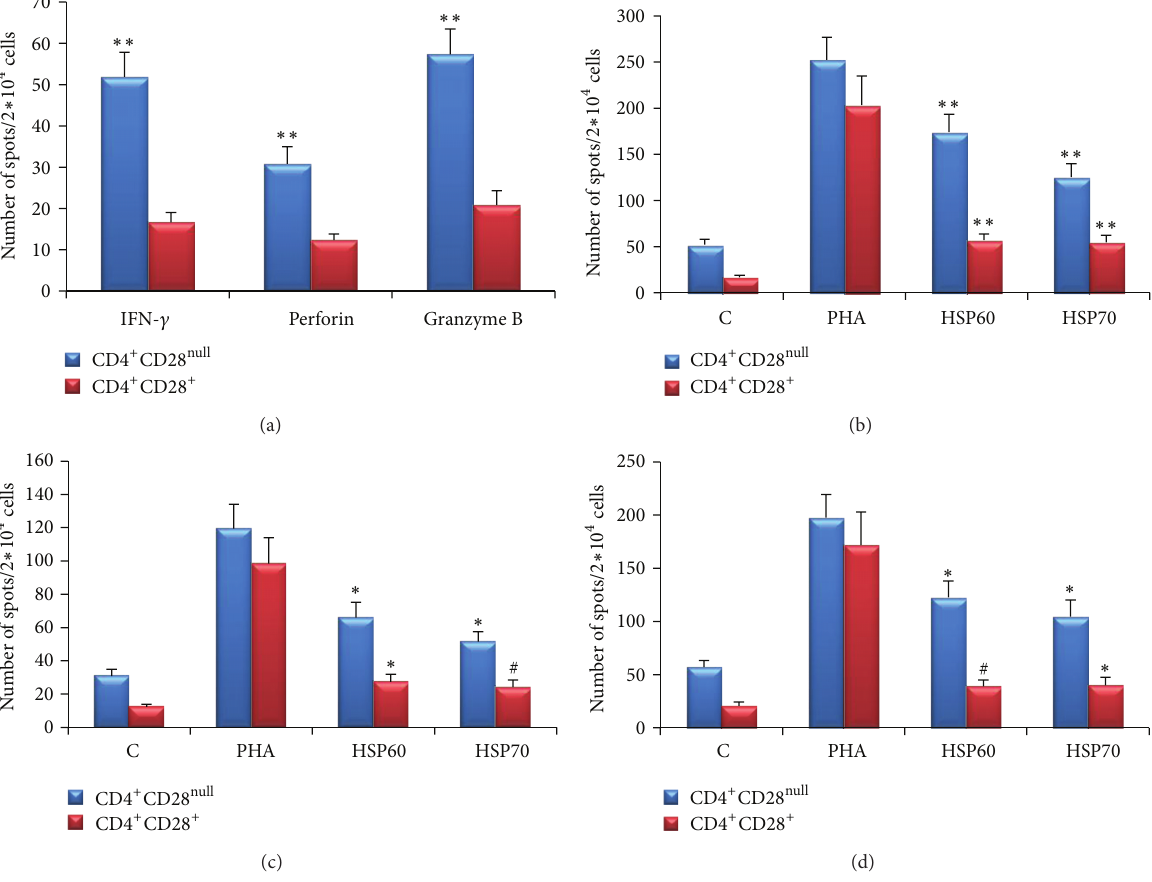
Figure 5: Elispot counts of IFN- 𝛾 , perforin, and granzyme B in CD4 + CD2 8 null cells and CD4 + CD28 + cells in CKD subjects. (a) Unstimulated cells: expression of IFN- 𝛾 , perforin, and granzyme B was significantly higher in CD4 + CD2 8 null T-cells. Elispot counts of (b) IFN- 𝛾 , (c) perforin and (d) granzyme B were significantly increased after 48hr stimulation with HSP60 (5ng/mL) and HSP70 (5ng/mL) as compared to unstimulatedcontrolinCD4 + CD2 8 null cellsaswellasCD4 + CD28 + cells.PHA(10 𝜇 g/mL)servedaspositivecontrol. ∗∗ 𝑃 < 0.0001 , ∗ 𝑃 < 0.001 , # 𝑃 < 0.01